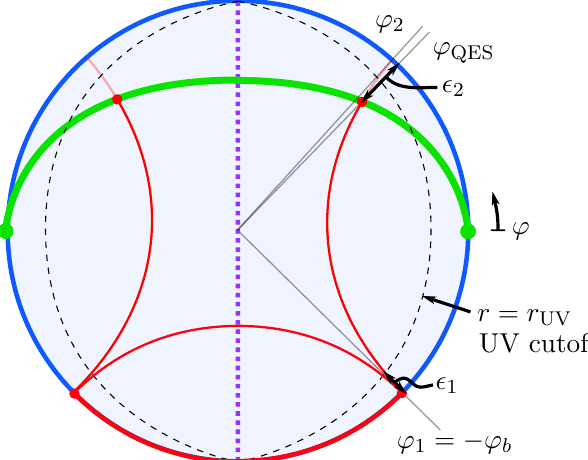
Figure 23. A slice of constant global time in AdS 3 , showing the two phases of the generalized entropy. The two cutoffs (cid:15) 1 , 2 involved in the computation are associated to the UV cutoff at the asymptotic boundary and the brane, respectively. The global coordinate angles ϕ 1 , ϕ 2 relate to the RT surface opening angle, while ϕ QES is the angle at which the RT surface intersects the brane and corresponds to the boundary of the island. Recall the geometry is cut at the brane and continued by gluing it to another